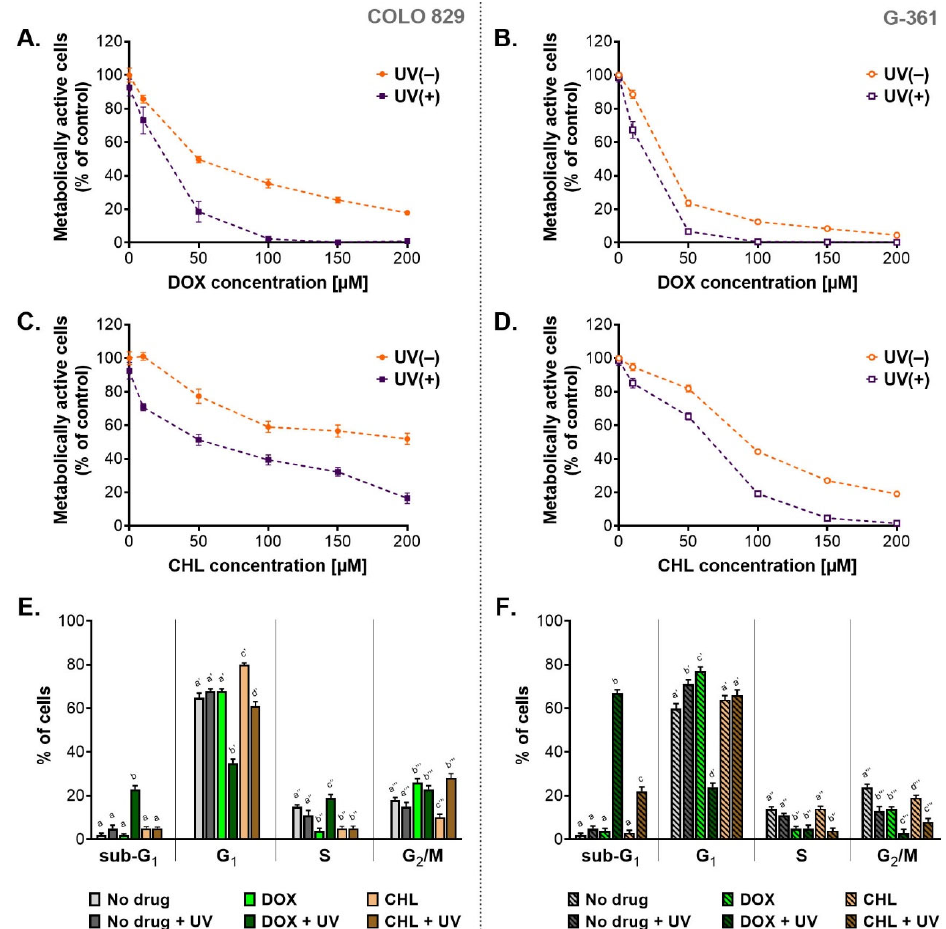
Figure 1. The assessment of cytotoxic and phototoxic effect of doxycycline and chlortetracycline on melanotic melanoma cell lines. The analysis of the number of metabolically active cells based on the WST-1 assay ( A – D ). Results of the cytometric analysis of the cell cycle ( E,F ). All graphs present mean values ± SD. Using different letters to show statistical significance. Table 1. Calculated values of EC 50 and PIF for doxycycline and chlortetracycline after the treatment of melanotic melanoma cell lines COLO 829 and G-361.